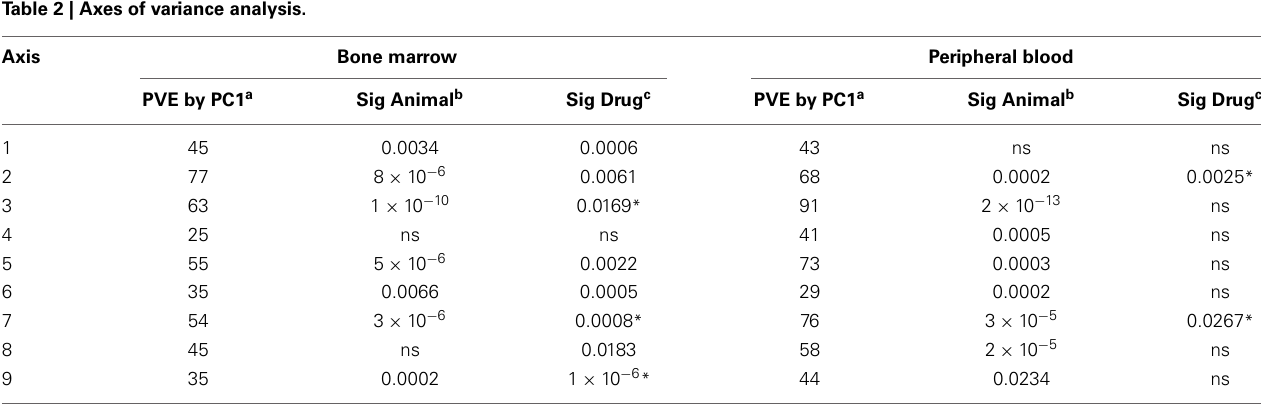
Table 2 | Axes of variance